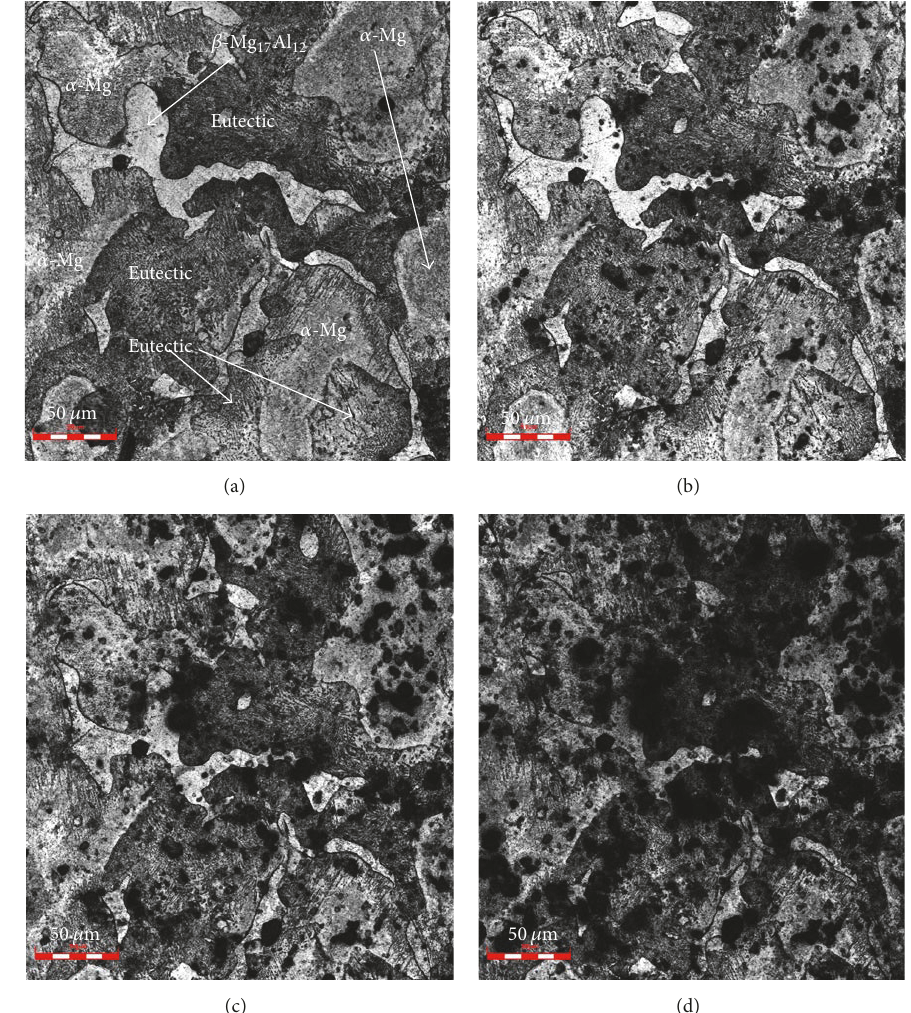
Figure 9: CLSM micrographs showing the evolution of the corrosion process of the AZ91D alloy in 3.5 wt.% NaCl solution at room temperature: (a) 6 h; (b) 15 h; (c) 40 h; (d) 72